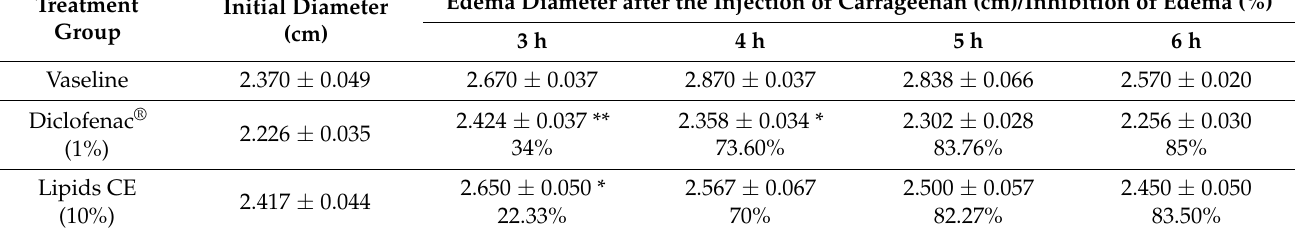
Table 4. Anti-inflammatory effect of lipid extract on carrageenan-induced paw edema in Wistar rats after 3, 4, 5, and 6 h of the